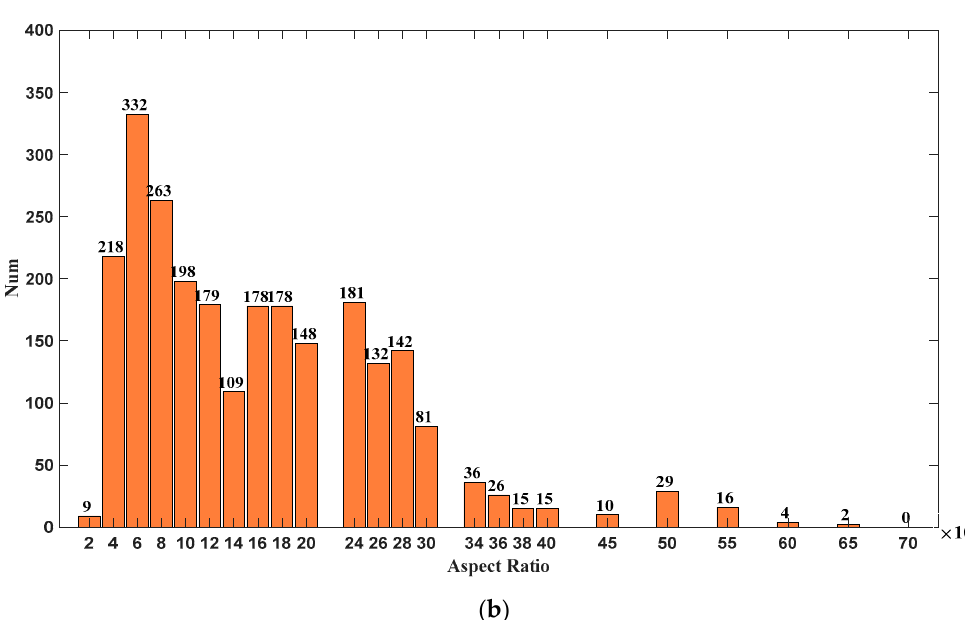
Figure 13. Statistical results of ship target bounding box in the SSDD : ( a ) Statistical results for the length of the ship target bounding box in the SSDD ; ( b ) Statistical results for the aspect ratio of the ship target bounding box in the SSDD.